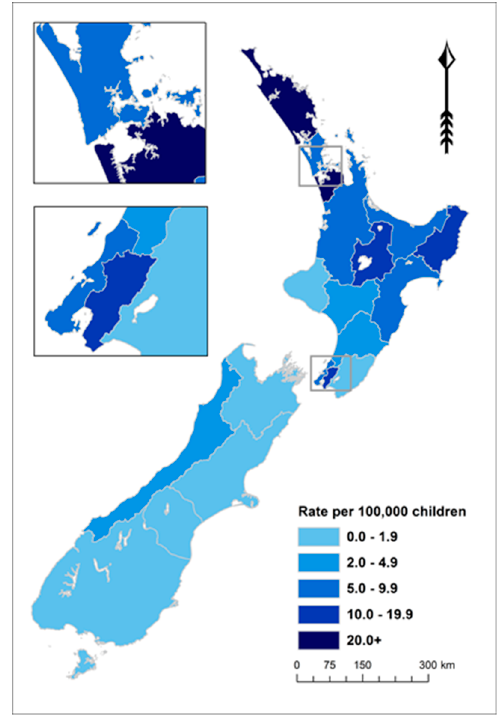
Figure 3. ARF incidence by District Health Board (DHB) for children aged <20 years, average annual initial hospitalisation rate per 100,000, 2010–2014.